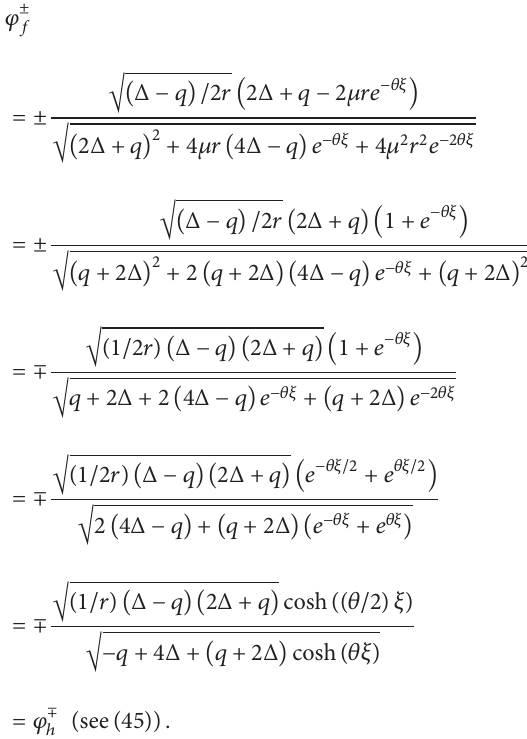
Figure 12: (The two pairs of 1-blow-up waves are bifurcated from the four pairs of 1-blow-up waves.) The varying process for the figures of 𝜑 ± 𝜇 < 0, 𝜇 ̸= − |𝜇 |, (𝑞,𝑝) ∈ 𝐴 𝑝 → 3𝑞 2 /16𝑟 + 0 , where 𝑟 = 1 , 𝑞 = −4, 𝑙 𝜑 ± 0 4 , and 𝑒 and 𝑓 when 𝑝 = 3 + 10 −2 , (b) 𝑝 = 3 + 10 −4 , (c) 𝑝 = 3 + 10 −6 , and (d) 𝑝 = 3 + 10 −9